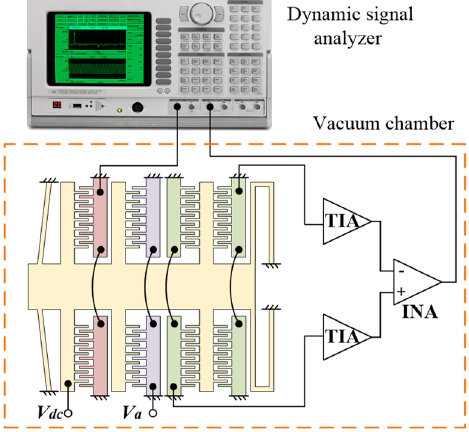
Figure 6. Frequency response circuit.